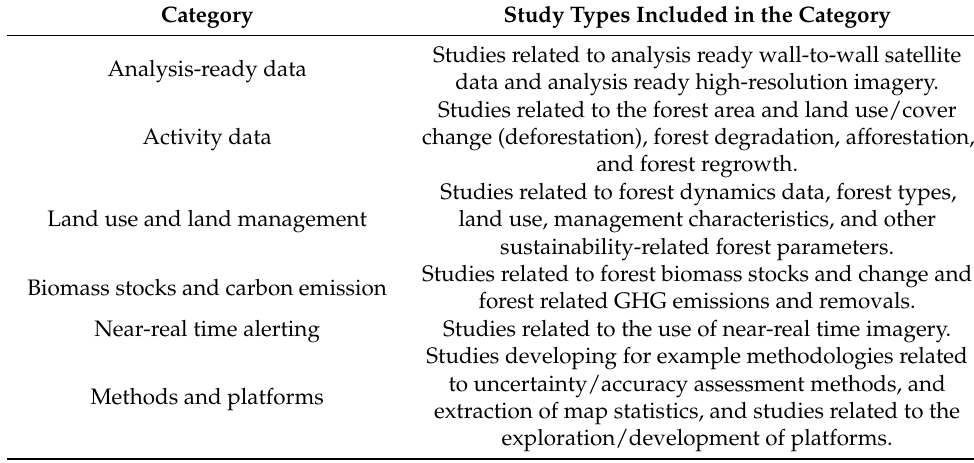
Table 1. Classification of the study categories observed with the literature review. Category Study Types Included in the Category Analysis-ready